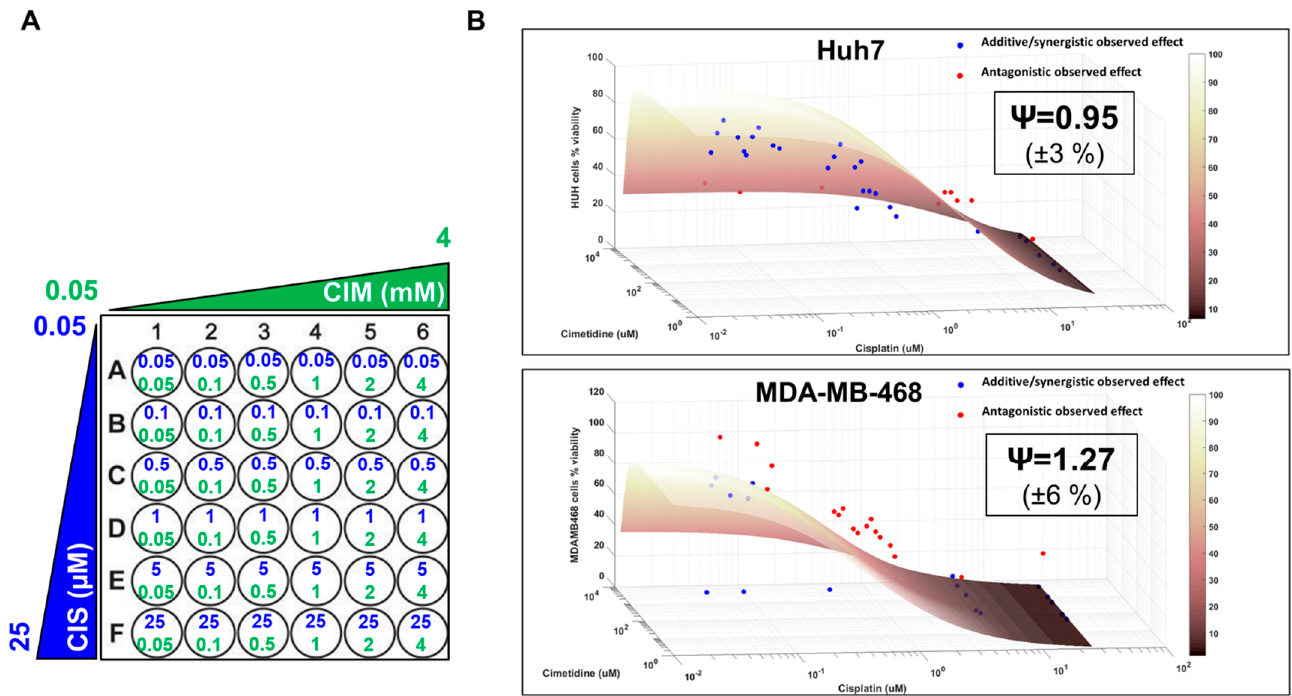
Figure 2. Three-dimensional response surface plots from the effects of single agents (CIS or CIM) and their combination data in Huh7 and MDA-MB-468 using a competitive interaction model. The concentrations used for single agents, CIS (0.05 to 25 µM) or CIM (0.05 to 4 mM) and their combinations are summarized in A . The 3D response surface plots represent model simulations under the assumption of an additive interaction ( ψ = 1) while the circles represent observed data for Huh7 ( B , top) and MDA-MB-468 ( B , bottom), respectively. Red circles are above the surface and indicate antagonistic interactions while blue circles are at or below the surface and indicate additive or synergistic interactions between CIS and CIM. ψ = 0.95 and ψ = 1.27 indicate interaction parameters estimated using a competitive interaction model for Huh7 and MDA-MB-468 cells, respectively.